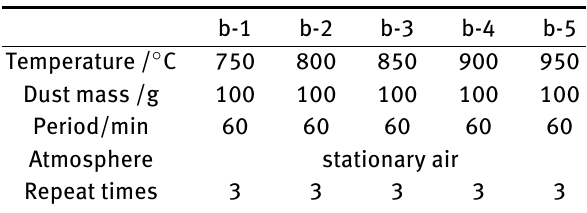
Table 3: Schemes for experiment (b) involving at different roasting temperatures